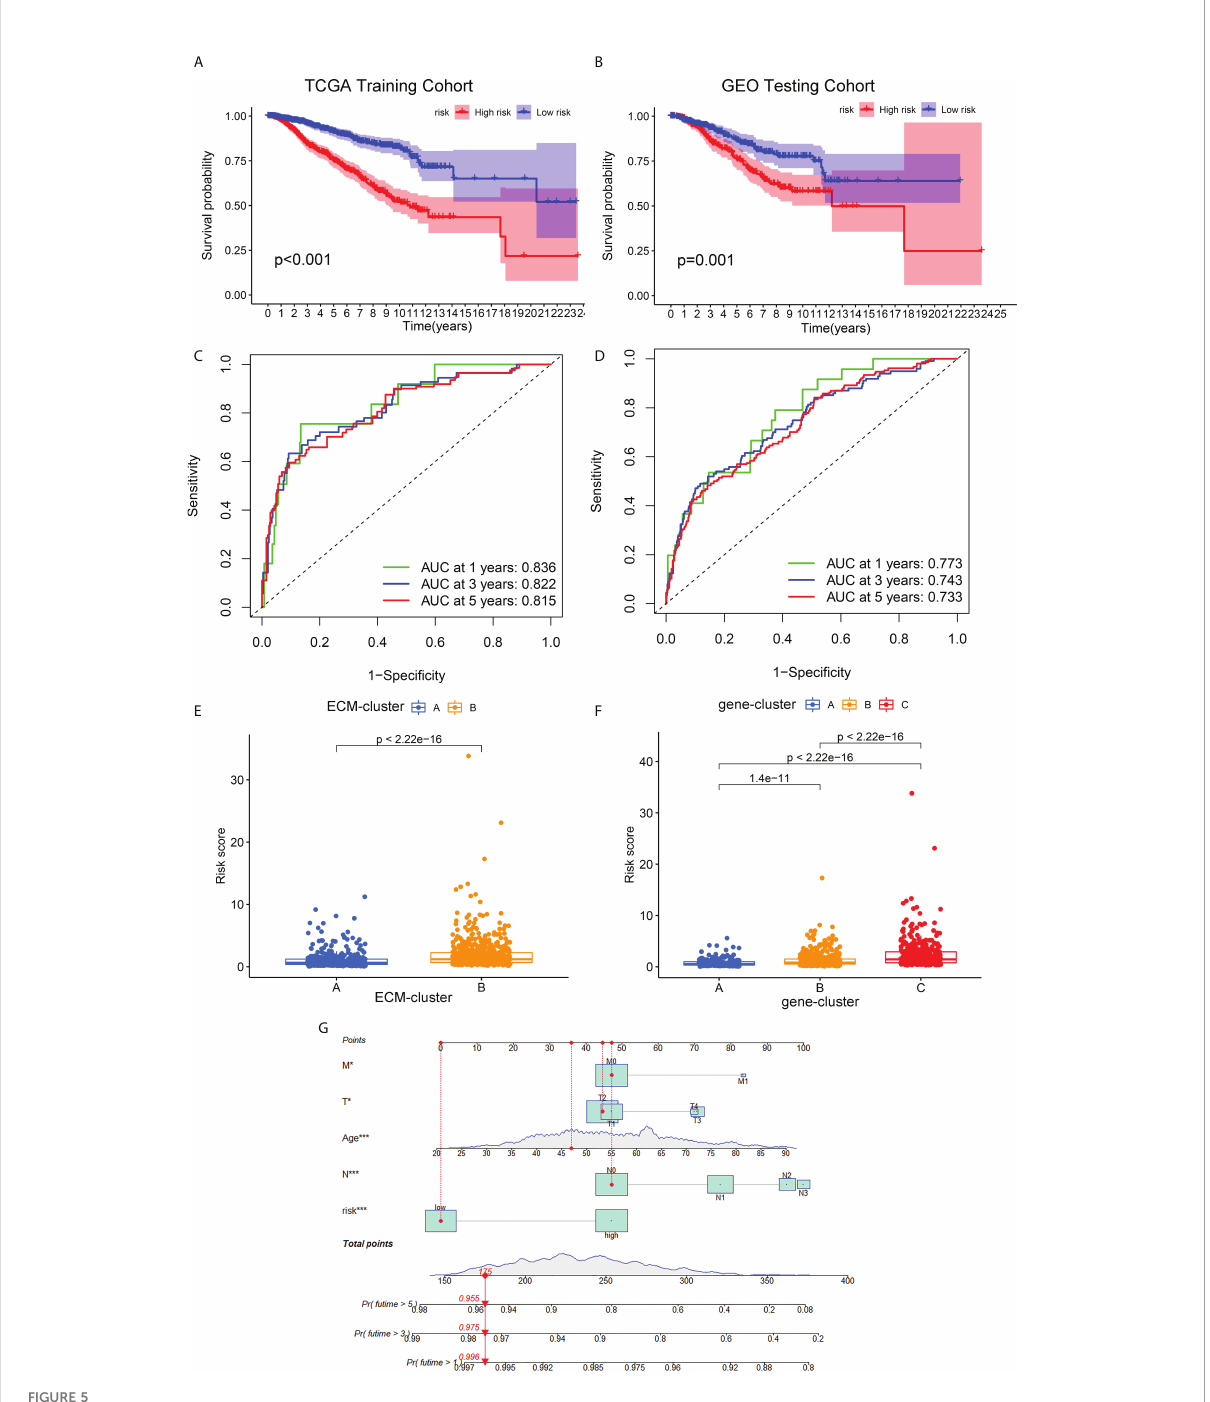
FIGURE 5 Development and validation of the ECM-associated prognostic model for breast cancer patients. (A) Kaplan-Meier survival analysis showed the OS differences of breast cancer patients in different risk groups from TCGA training cohort. (B) Kaplan-Meier survival curve of OS of breast cancer patients from GEO testing cohort. (C) AUC of time-dependent ROC curves to evaluate the predictive ef fi cacy of the prognostic model in TCGA training cohort. (D) AUC of time-dependent ROC curves to evaluate the predictive ef fi cacy of the prognostic model in GEO testing cohort. (E) Distribution of risk scores of breast cancer patients in different ECM-clusters. (F) Distribution of risk scores of breast cancer patients in different gene-clusters. (G) Nomogram for predicting 1-, 3- and 5-year survival of breast cancer patients constructed by combining risk scores and clinical parameters. OS, overall survival; GEO, Gene Expression Omnibus; AUC, area under the curve; ROC, receiver operating characteristic curve; * p <0.05; *** p